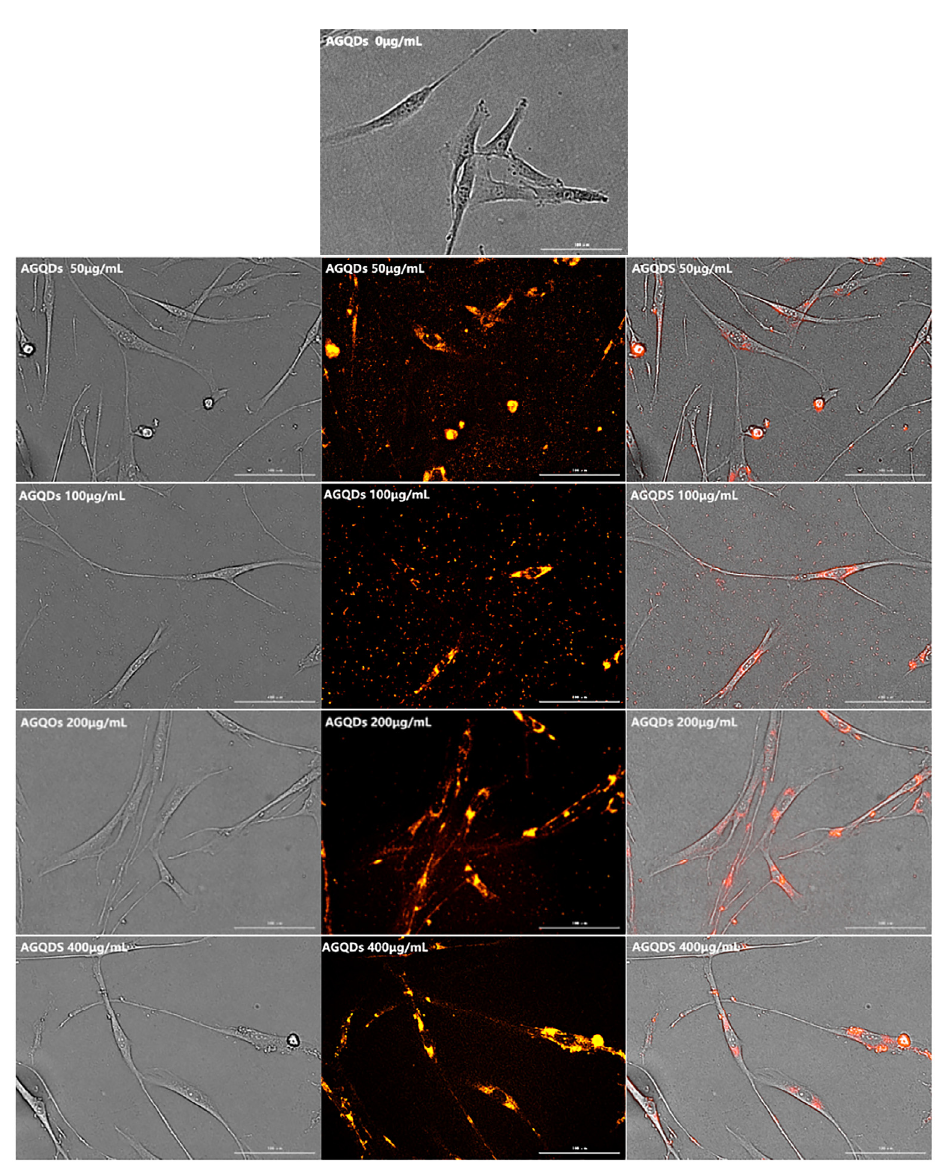
Figure 11. The fluorescence map of HSFs labeled with AGQDs. Scale bars: 100 μ m.